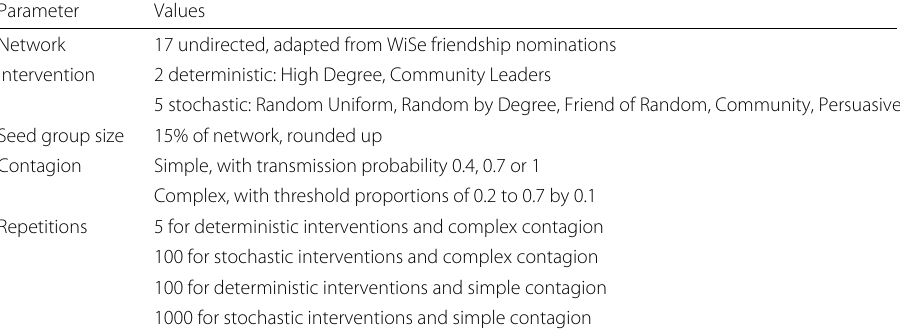
Table 4 Experimental design: simulation parameters and number of runs